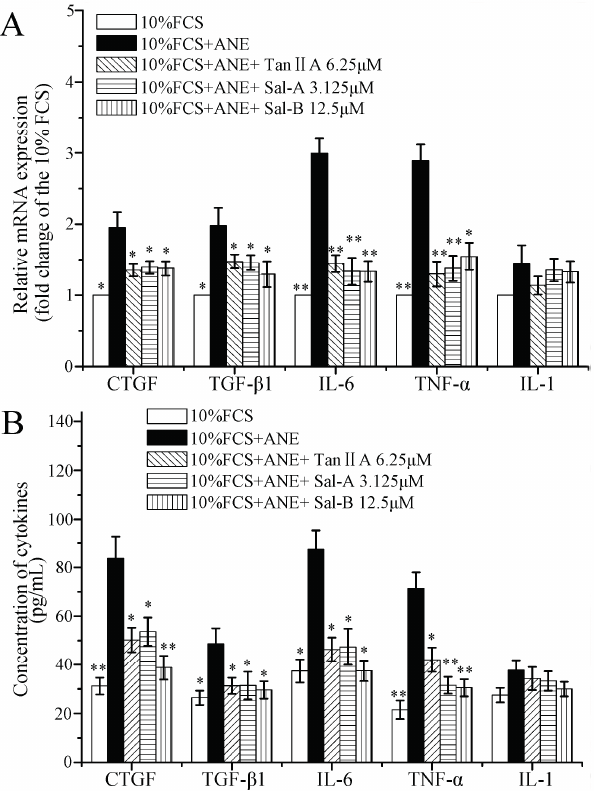
Figure 5. Influence of Tan-IIA, Sal-A and Sal-B on the transcription and release of cytokines after ANE treatment. MOMFs were exposed to ANE (12.5 μ g/mL), with or without Tan-IIA (6.25 μ M), Sal-A (3.125 μ M) and Sal-B (12.5 μ M) for 48 h. The cells were harvested and used in qRT-PCR assay ( A ); and the supernatants were collected and used in ELISA assay ( B ). n = 5, * p < 0.05 and ** p < 0.01 vs. the FCS + ANE